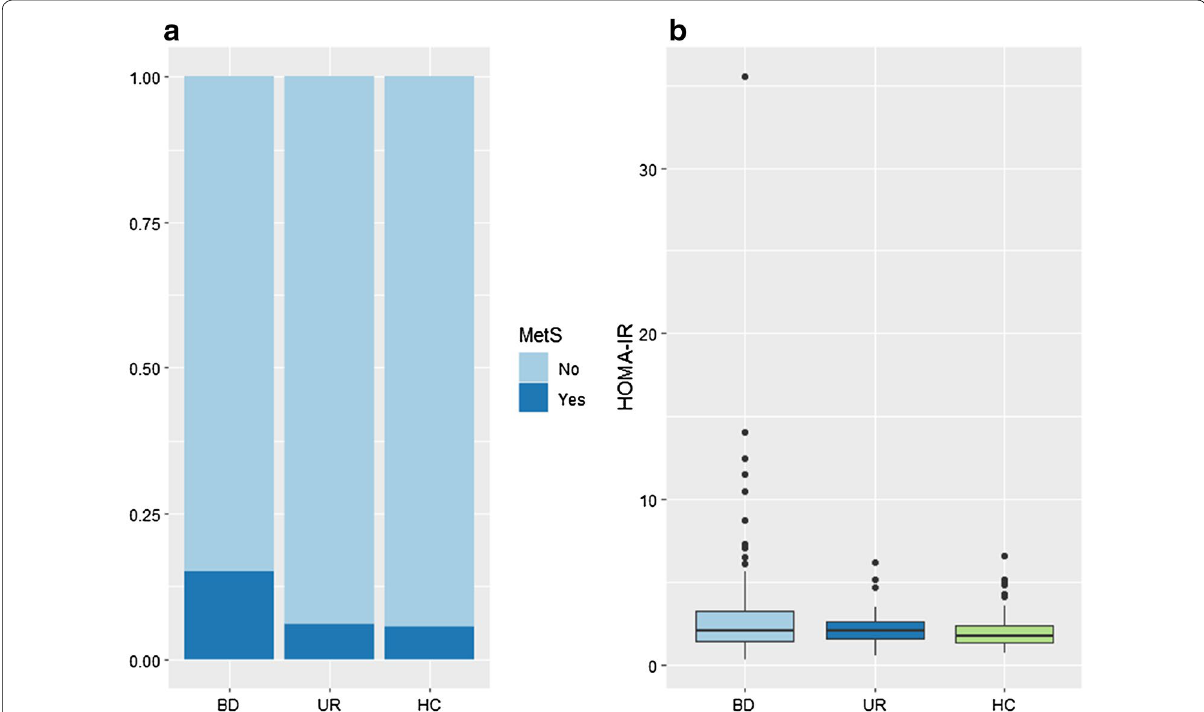
Fig. 1 a Clustered bar chart of metabolic syndrome and b box plot of insulin resistance in patients with newly diagnosed bipolar disorder (BD), their unaffected first-degree relatives (UR) and healthy individuals (HC). The lower and upper hinges in the box plot correspond to the first and third quartiles and the upper and lower whiskers extend from the hinge to the largest and lower value, respectively, no further than 1.5 times the interquartile range from the hinge. Data beyond the end of the whiskers are plotted individually. MetS: metabolic syndrome; HOMA-IR: homeostasis model assessment of insulin